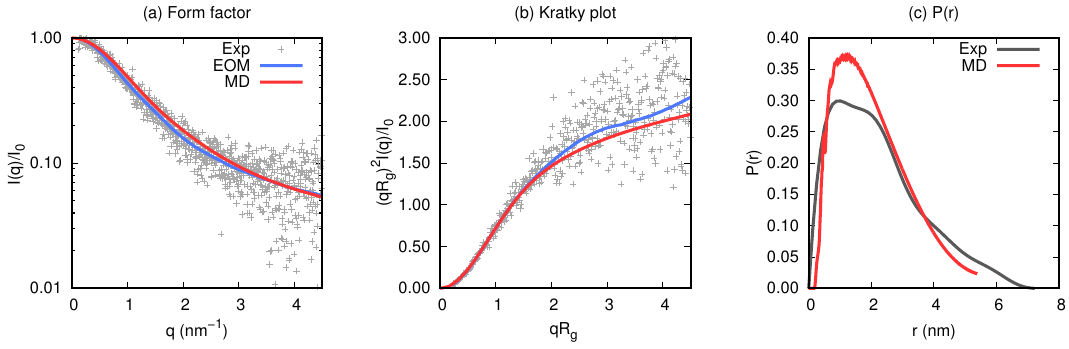
Figure 4. Experiment small-angle X-ray scattering (SAXS) results (grey) compared to ensemble-optimisation-method (EOM; blue) and molecular-dynamics (MD) simulations (red). ( a ) Form factors, ( b ) Kratky plot, and ( c ) distance-distribution functions.